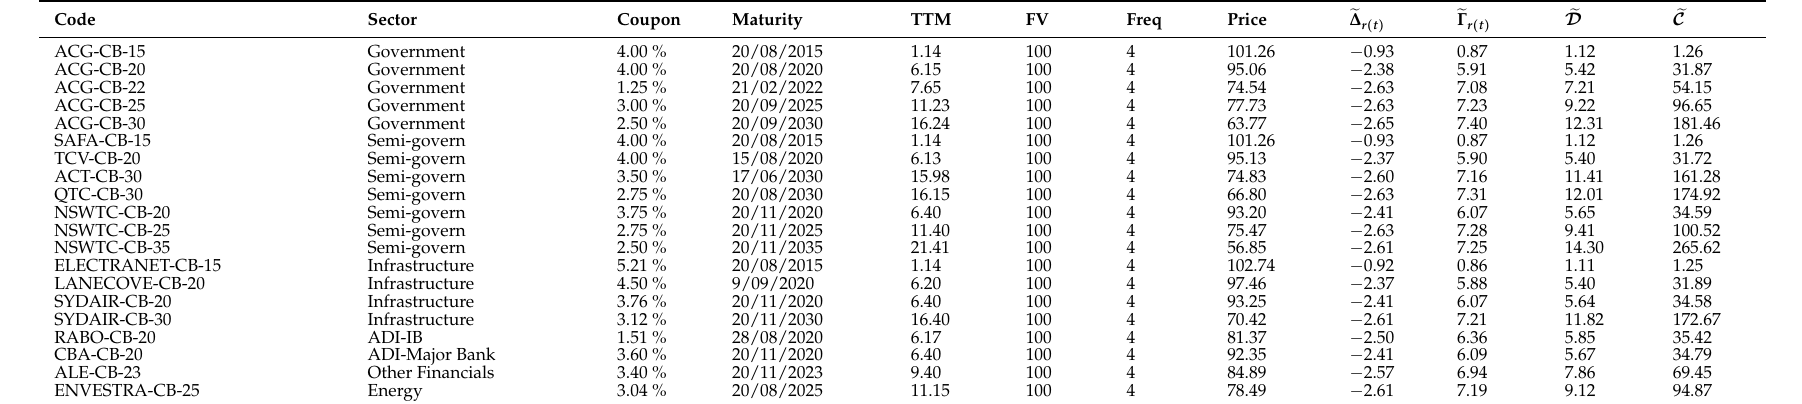
Table 8. These are hypothetical coupon paying bonds with coupons and maturities corresponding to index linked bonds available on the FIIG web site. We do not include inflation in the analysis so we have used these as hypothetical coupon paying bonds with quarterly frequency. These hypothetical bonds have longer duration compared to the Government Coupon bonds. They also have quarterly coupon cash flows.